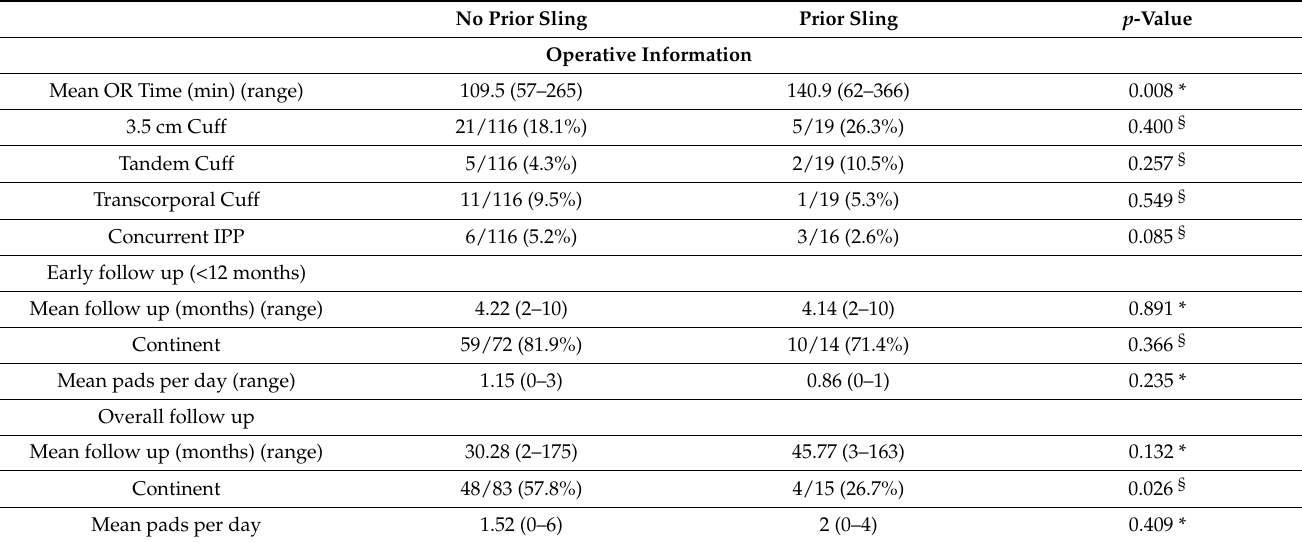
Table 2. Intraoperative Characteristics and Postoperative